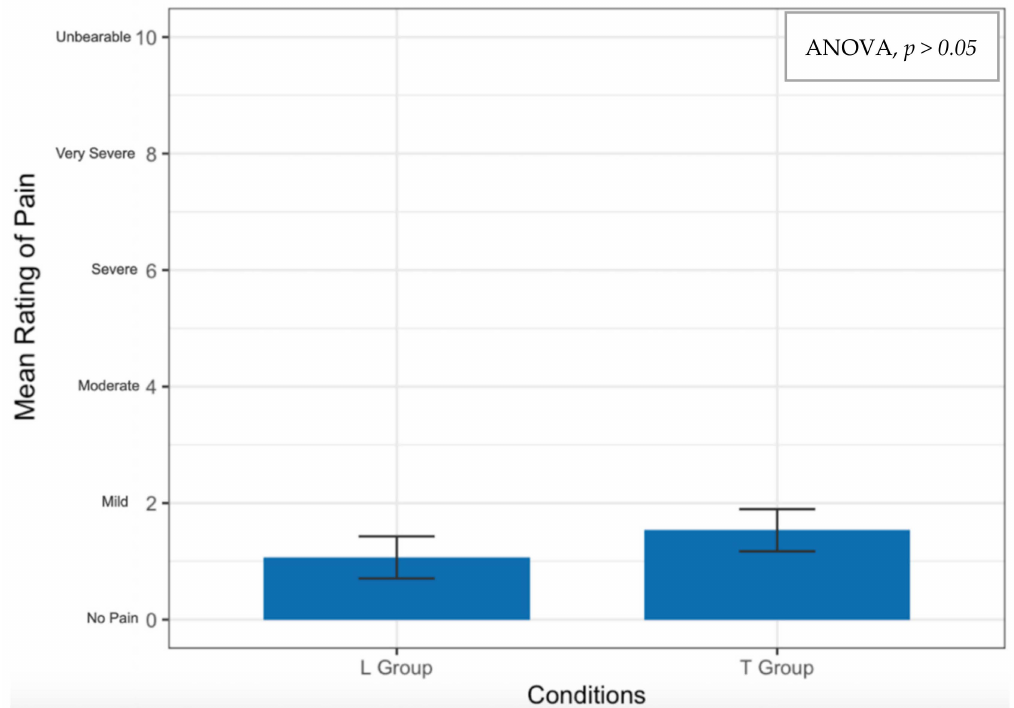
Figure 3. Illustrates the mean ratings of pain with associated standard deviation for both groups (L and T), where 0 represents no pain and 10 represents unbearable pain. Abbreviations: T Group: 20% benzocaine topical gel + placebo laser; L Group: photobiomodulation + placebo